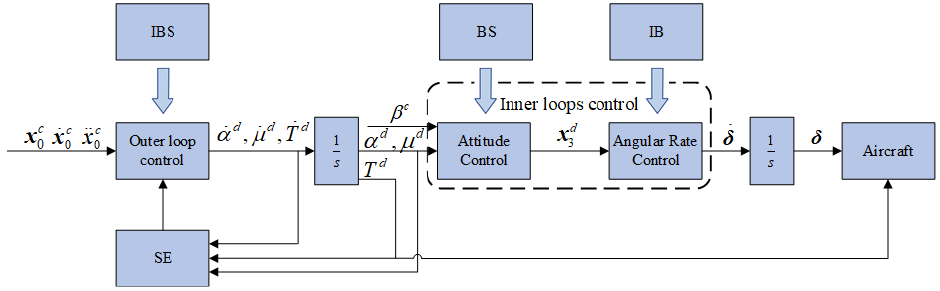
Figure 1. Control